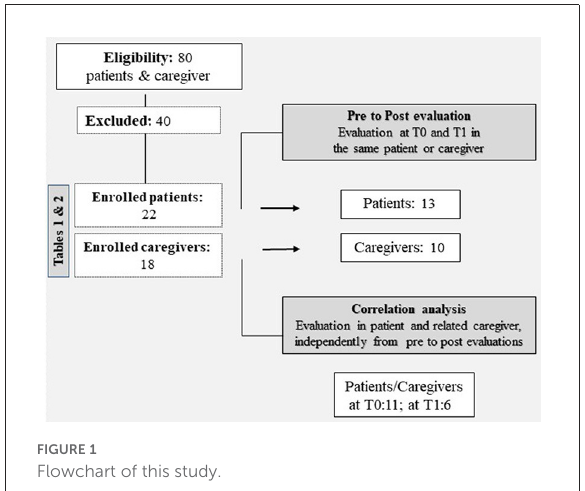
FIGURE1 Flowchart of this